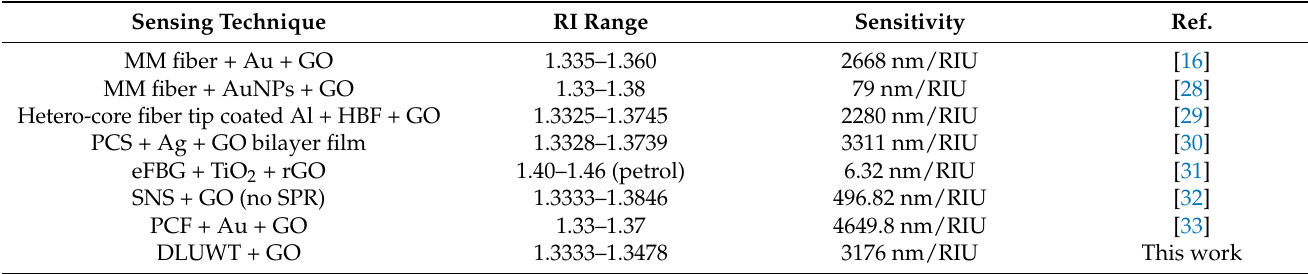
Table 1. Comparison of the sensitivity of several configurations incorporating graphene oxide.